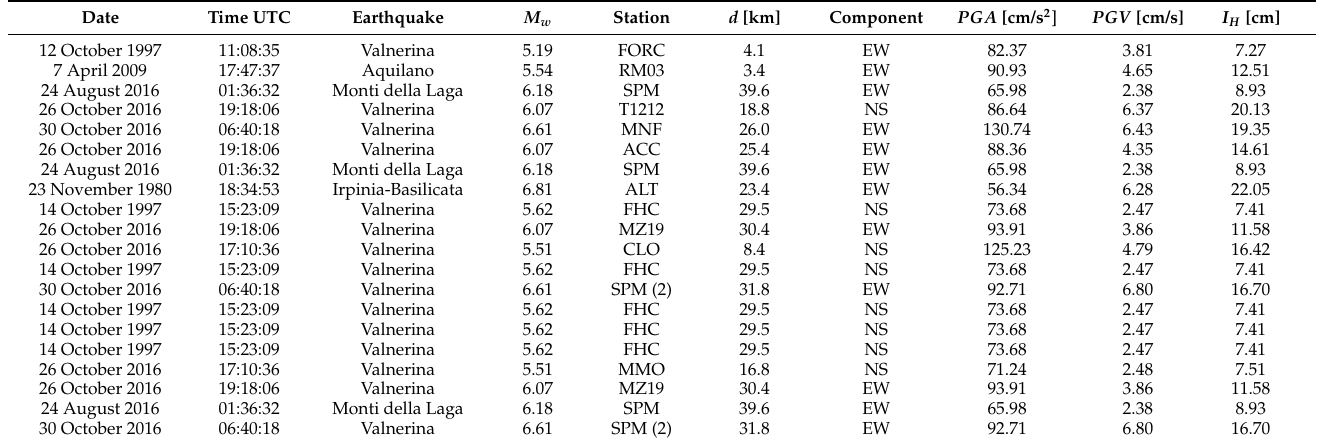
Figure 4. Correlation between historical events and recorded events reproducing the seismic history in terms of: ( a ) magnitude M w , ( b ) epicentral distance d . Table 2. List of recorded accelerograms used to reproduce the seismic